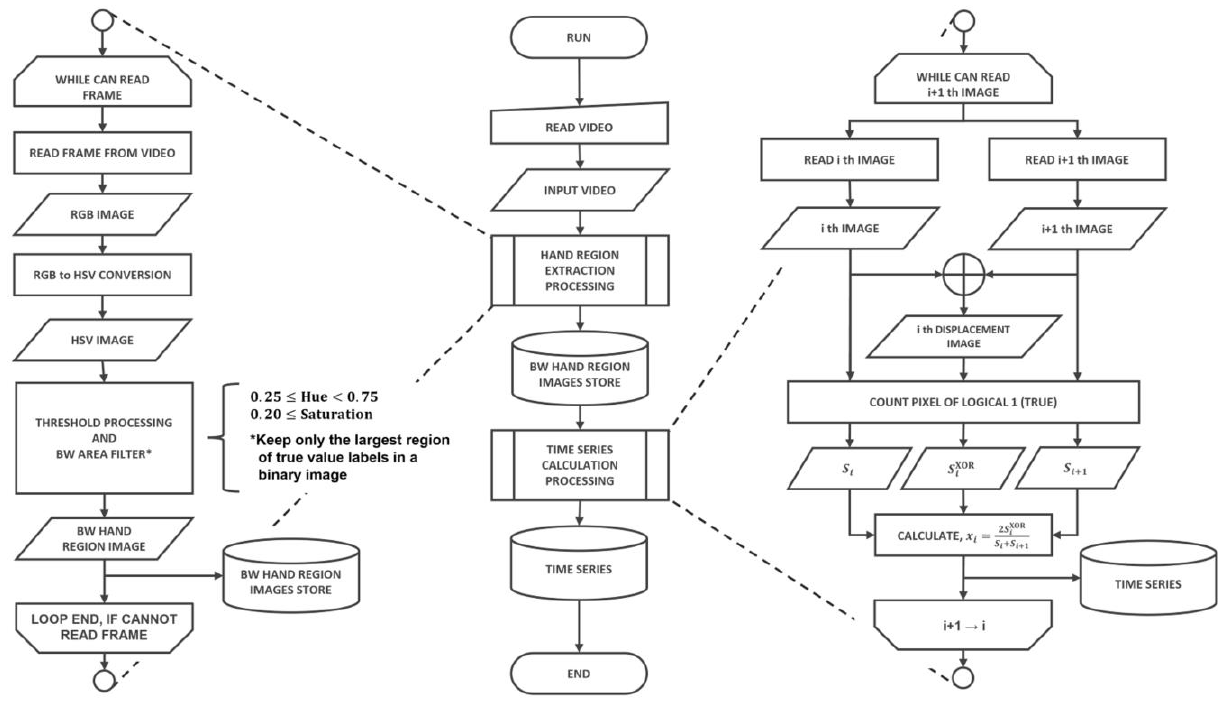
Figure 3. The flowchart of time series extraction from selected video input.